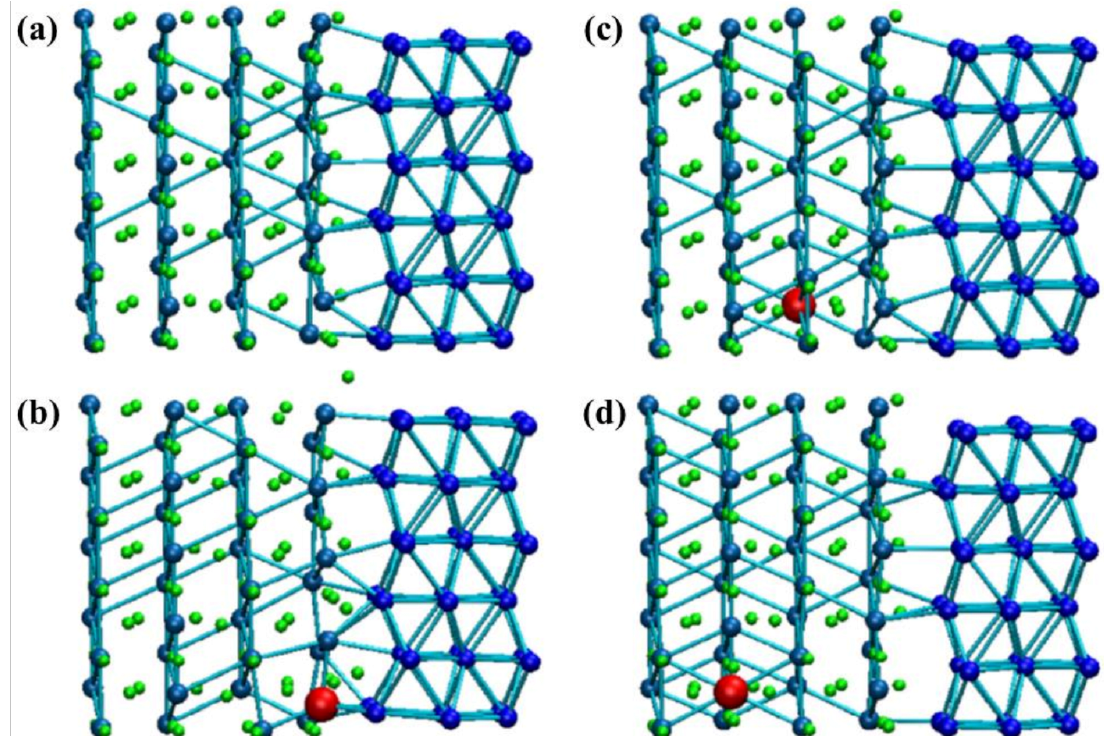
Figure 34. Snapshots of the MgH 2 –Mg interface without Fe catalyst and with Fe in POS1 (first Mg layer in the MgH 2 side), POS2 (second Mg layer in the MgH 2 side), and POS3 (third Mg layer in the MgH 2 side) at the end of ionic relaxation: panels ( a ), ( b ), ( c ), and ( d ), respectively. H atoms are in green, Mg atoms are in light (MgH 2 side) and dark (Mg side) blue, and the Fe atom is in red. ( a – d ) Reproduced with permission [253]. Copyright 2013,